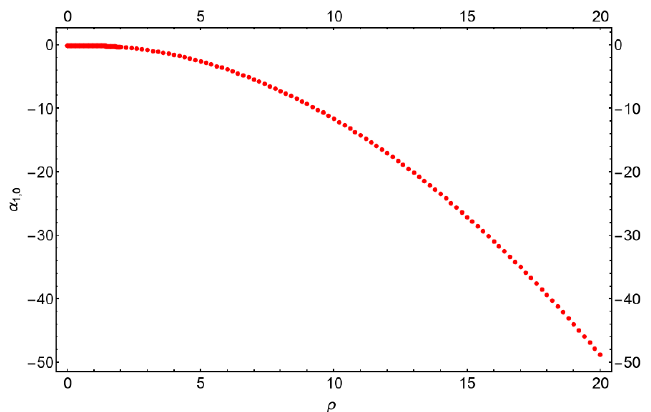
(cid:0) (cid:11) 2 for M = S 2 (cid:2) S 4 , where S 2 shrinks. 1 ; 0 1 ; 0